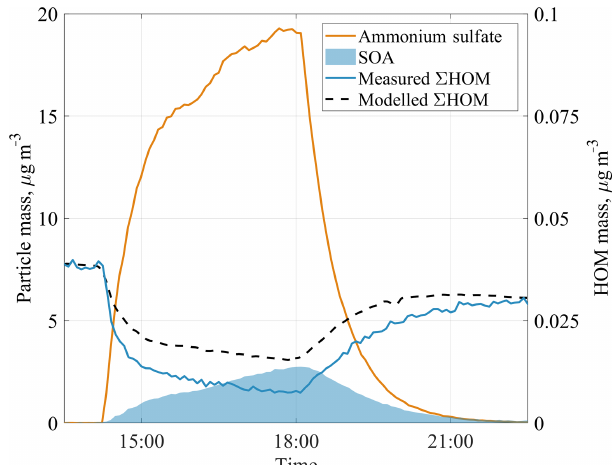
Figure 6. The evolution of components of aerosol mass and HOM mass concentrations during a seed aerosol experiment. The mod- elled total HOM concentration (dashed line) underestimates the re- moval of HOMs from the chamber when aerosol seed is added, suggesting that not only HOMs but also some HOM precursors de- crease during the seed